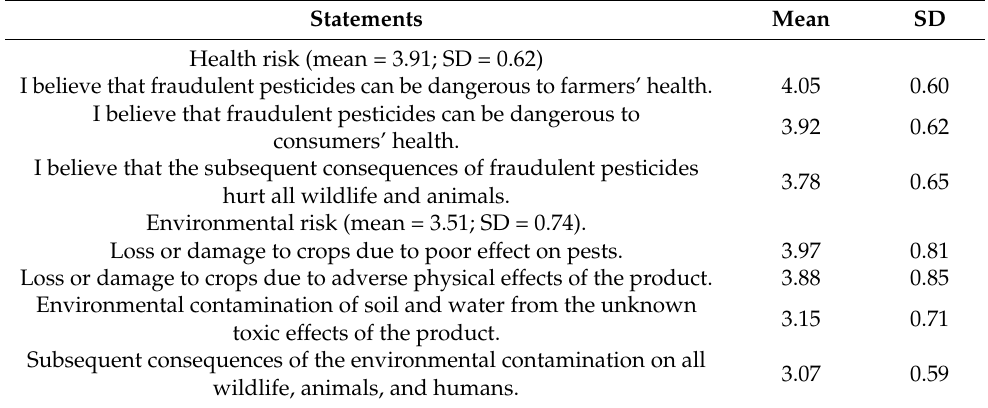
Table 3. Perception of the risks associated with fraudulent pesticides from the farmers’ point of view.